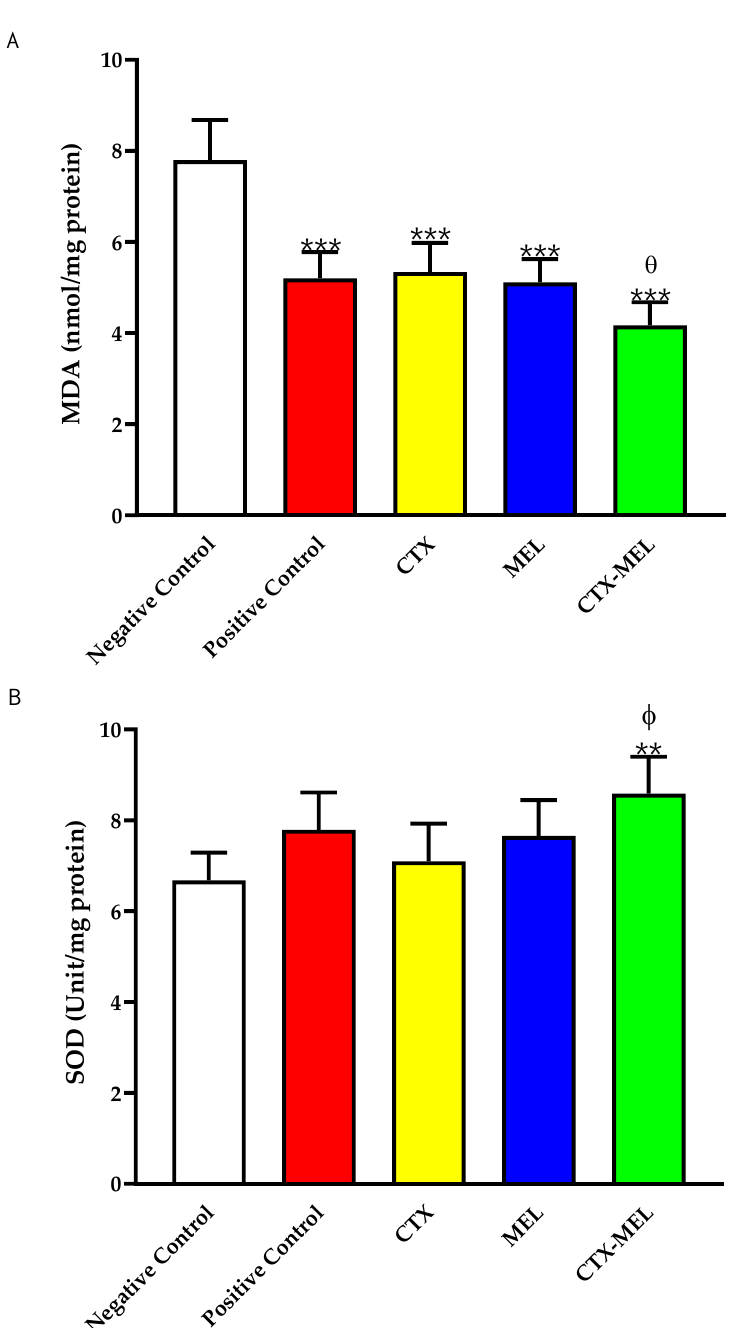
Figure 4. Effect of CTX, MEL, or CTX–MEL nanocomplex on ( A ) MDA and ( B ) SOD levels in wounded skin of diabetic rats. Negative control refers to rats that received topical plain vehicle consisting of HPMC-based hydrogel (1.5% w / v ) on the wound area, while positive control refers to animals that received 0.5 g of Mebo TM ointment on the wound area. Data are presented as mean ( n = 6) ± SD. ** Significantly different vs. negative control, p < 0.01; *** significantly different vs. negative control, p < 0.001; ϕ significantly different vs. CTX, p < 0.05; Ѳ significantly different vs. CTX, p < 0.05. Of note, the effect coming from the topical treatment with the optimized formula (CTX – MEL), e.g., the ability to decrease MDA levels, was paralleled by an enhancement of SOD levels (Figure 4B). The ability of CTX – MEL to increase the levels of this member of the antioxidant system was not observed neither in the case of the positive control nor in the case of CTX or MEL used individually.